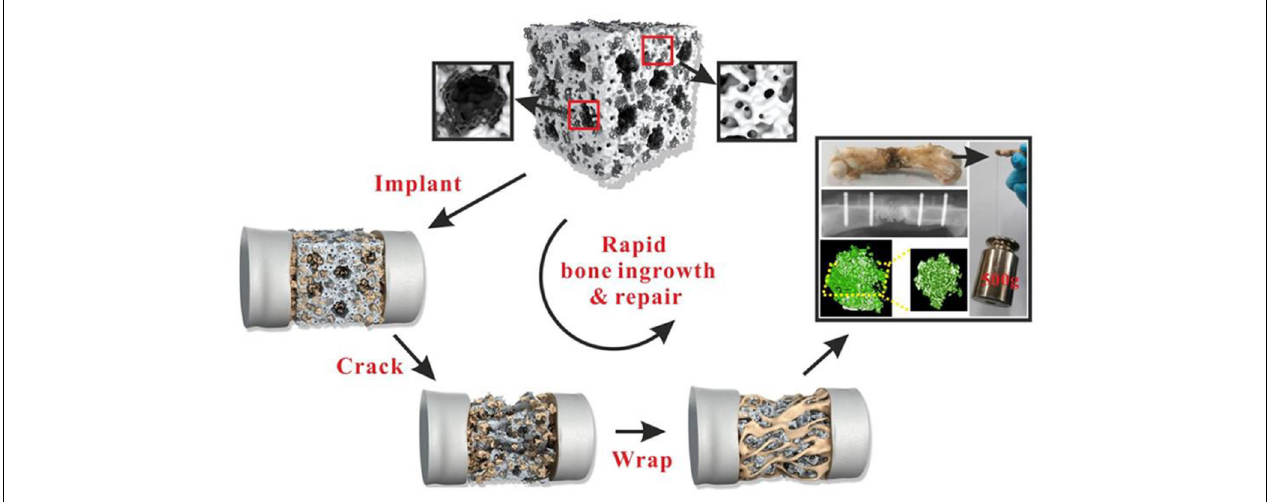
FIGURE 4 | Diagram of the formation mechanism of porous HA/rGO composite scaffold. Reproduced from Zhou et al. (2019) with permission from the American Chemical Society (Copyright